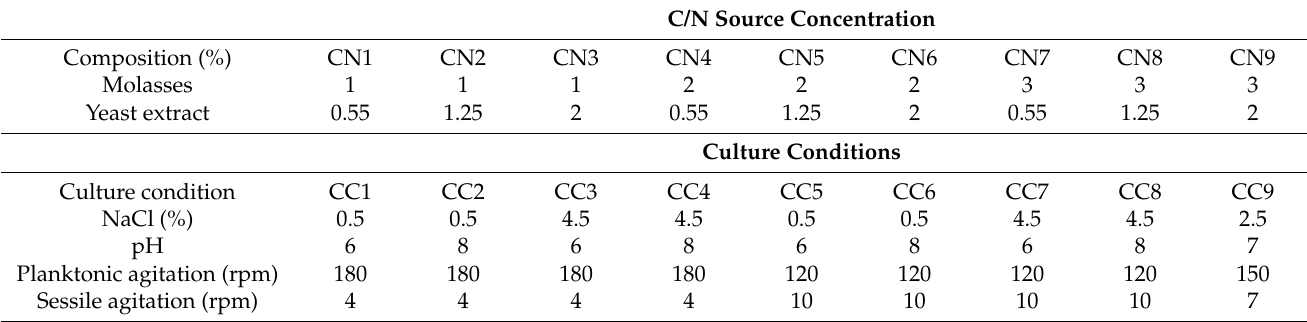
Table 1. Media composition (C/N source) and culture conditions for the BS and BE production of bacteria isolated from